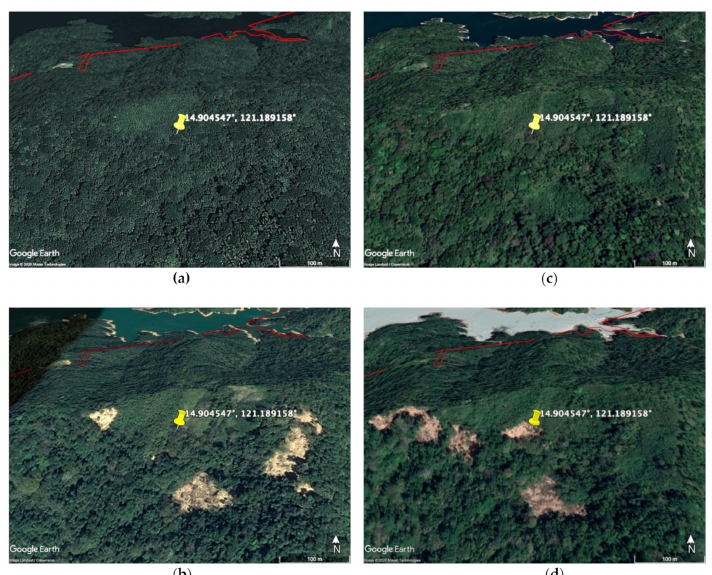
Figure 12. Actual changes in vegetation cover observed on ( a ) 2 November 2012; ( b ) 20 March 2015, ( c ) 16 March 2018; and ( d ) 26 March 2019, for a segment of the area within Site 3 (Pin location: 14.904547 ◦ , 121.189158 ◦ ) as observed using VHR RGB data accessed through Google Earth Pro.